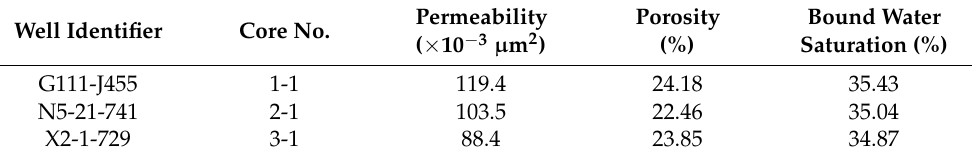
Table 1. Basic data of NMR core.